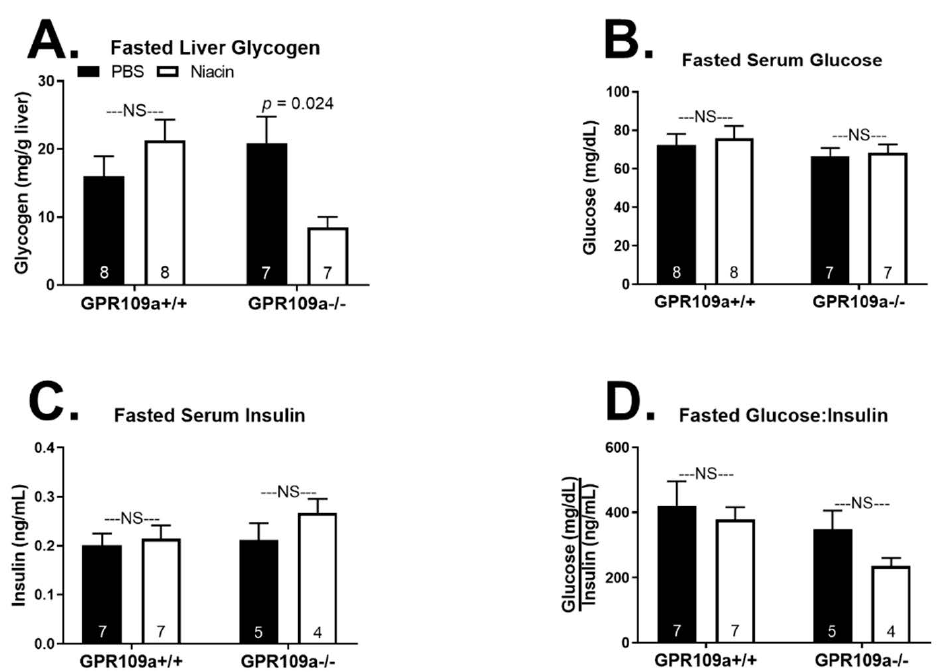
Figure 4. Effect of niacin on glucose homeostasis in 16 h fasted GPR109a +/+ and − / − mice. Hepatic ( A ) glycogen (mg/g liver tissue), serum ( B ) glucose (mg/dL), ( C ) insulin (ng/mL), and ( D ) glucose:insulin ratio. Direct comparisons were made between injection treatment within genotype. NS = non-significant; p > 0.05; PBS = phosphate buffered saline. Numbers inside bars denote the n per